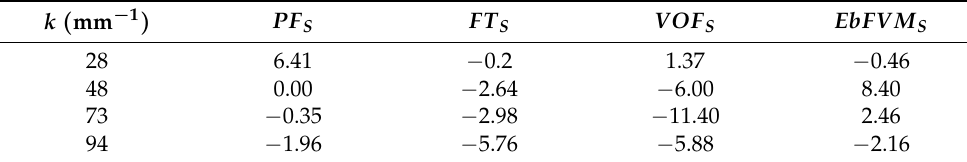
Table 3. Relative difference between computed critical amplitude values a c / g and linear theory